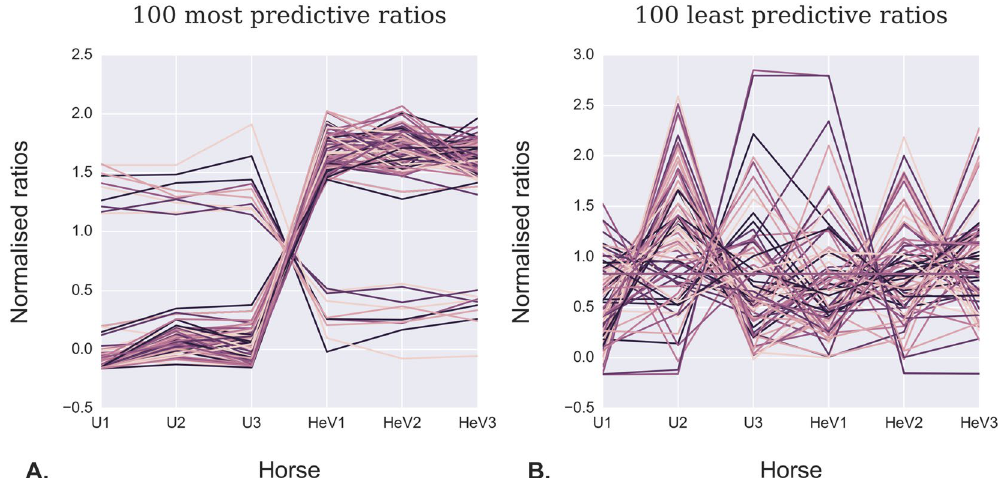
Figure 7. Ratios of pairs of miRNAs with the potential to distinguish infected from uninfected horses. All possible combinations of miRNA pairs were tested, and the ( A ) 100 most-predictive, and ( B ) 100 least- predictive miRNA pairs are